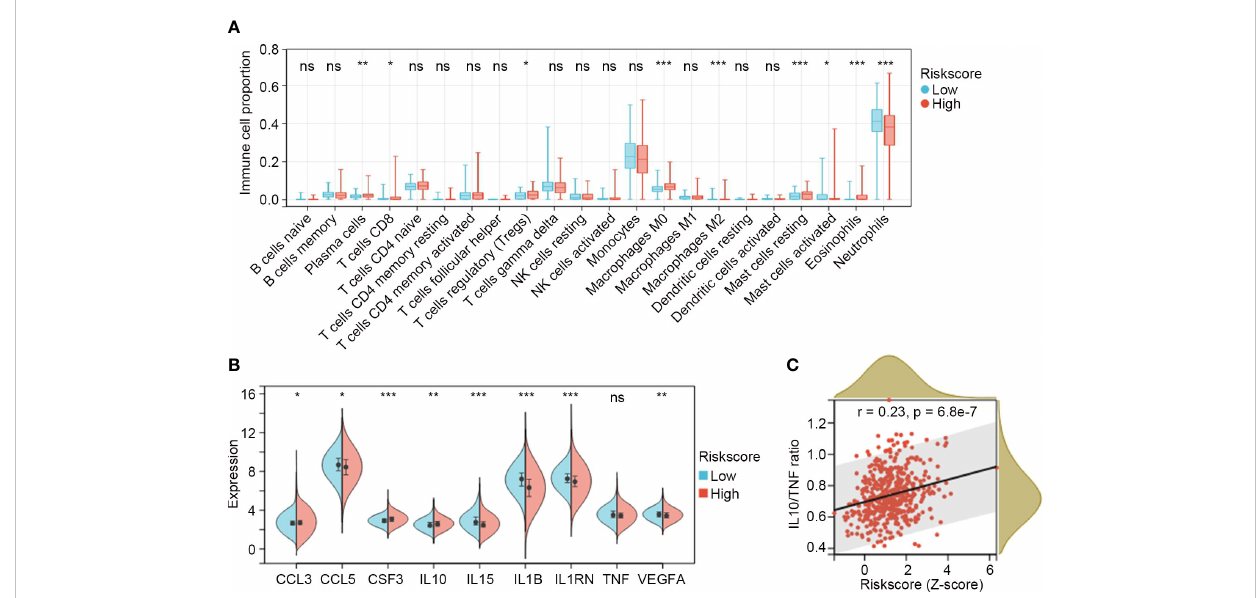
FIGURE 6 Distribution of immune cell subtypes and expression of cytokines and chemokines in the IRG subgroups. (A) Comparisons of immune cell fractions between low risk (n = 247) and high risk (n = 232) IRG subgroups in GSE65682. The Mann-Whitney U test was used to compare the differences. (B) Comparisons of cytokines and chemokines between low risk and high risk IRG subgroups. Differences were determined by the Mann-Whitney U test. (C) The relation between the IRG risk score and the ratio of IL10 / TNF in sepsis by Spearman correlation analysis. *P < 0.05, **P < 0.01, ***P < 0.001, ns, no signi fi cance.